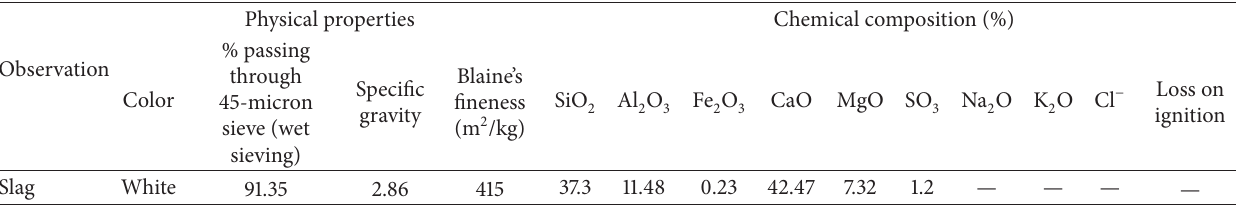
Table 1: Properties of GGBFS used in the